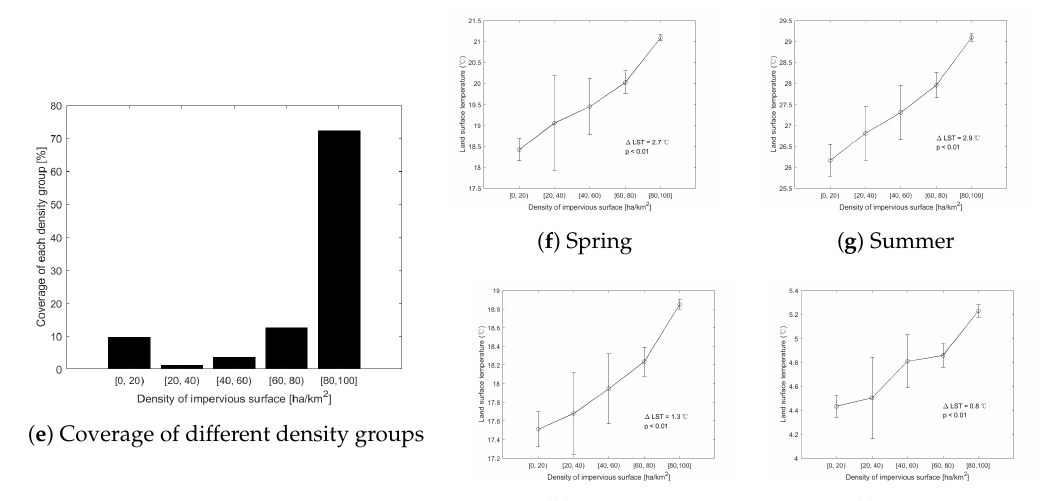
Figure 11. Density map of impervious surfaces for four seasons in Paris. Different colored areas and sized circles indicate various temperatures ( ◦ C) and different densities respectively. Figures ( f – i ) present the relationships between LST and density of green area with 95% confidence